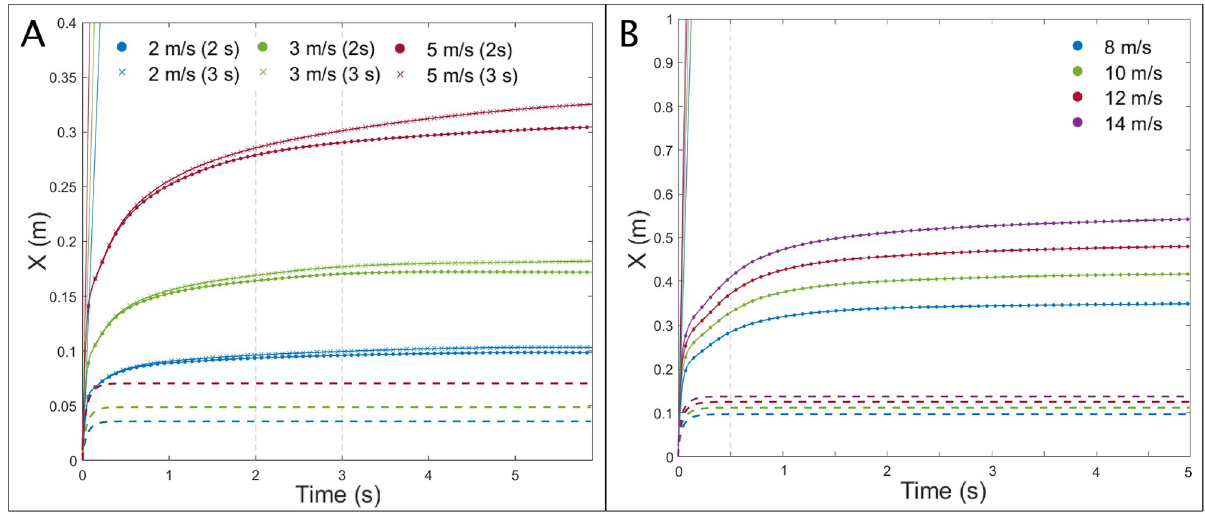
Fig 8. CFD simulations: Particle axial travel distance v time. Mean axial travel distance of droplets for (A) breathing over a 6 s interval after exhalation begins and (B) coughing over a 5 s interval after cough begins. The ballistic (solid lines) and stagnant air resistance (dashed lines) are also